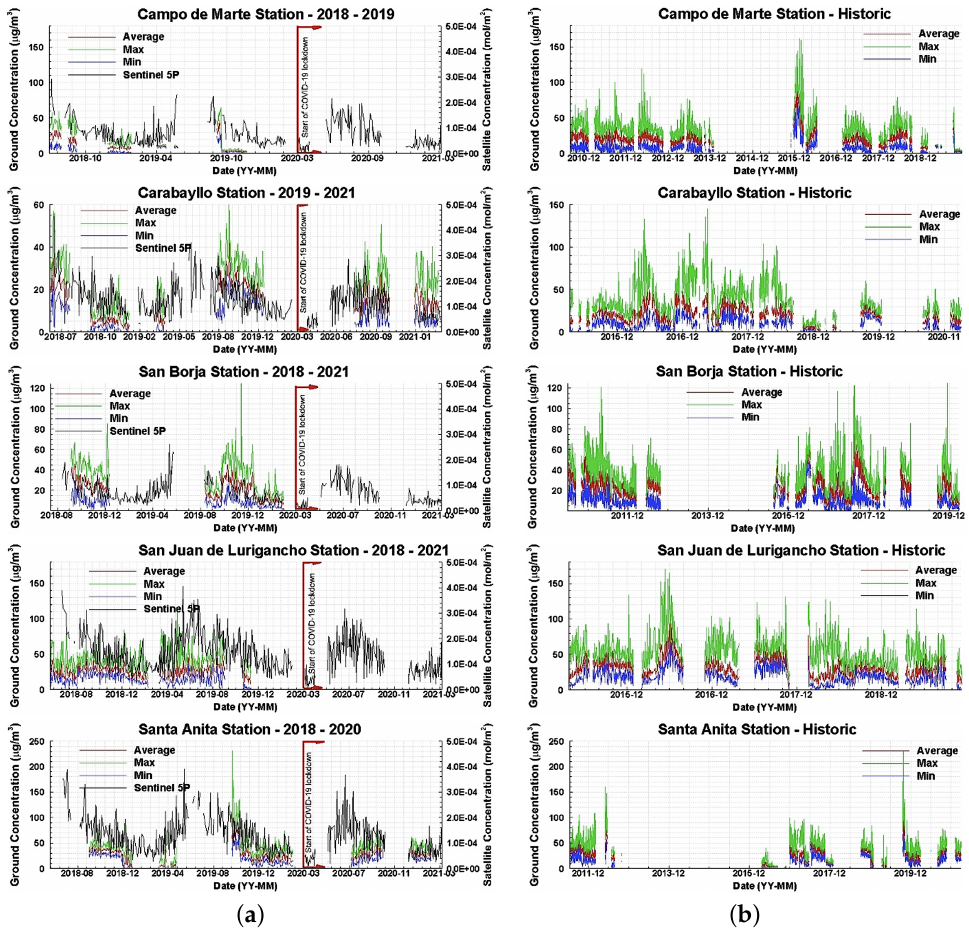
Figure 4. Comparison of the results, in terms of NO 2 levels using the data from the Sentinel-5 satellite (mol/m 2 ) and the official data of Peru from SENAMHI air quality stations (micrograms/m 3 ), located at ‘Campo de Marte’ station, ‘Carabayllo’ station, ‘San Borja’ station, ‘San Juan de Lurigancho’ station, and ‘Santa Anita’ station: ( a ) 2018–2021, and ( b ) historical